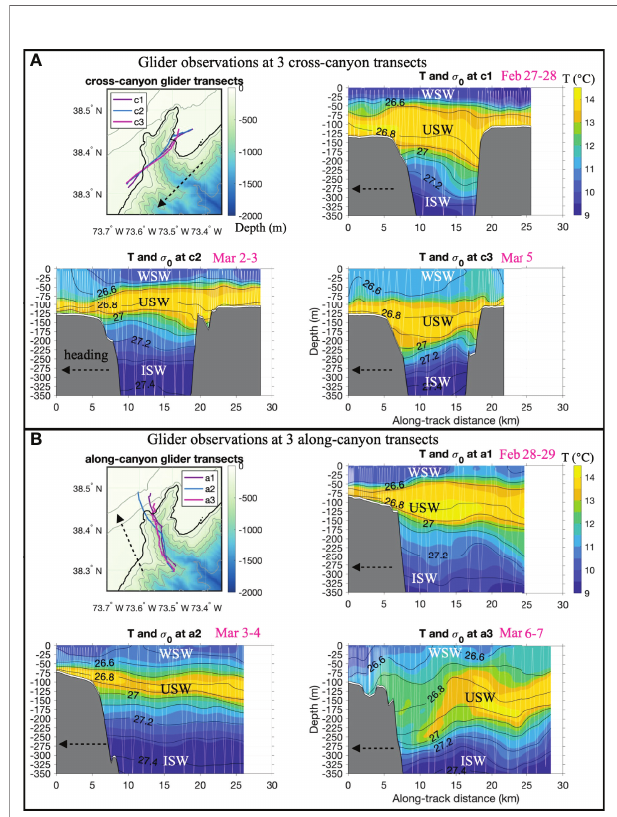
FIGURE 4 | Interpolated temperature (color) and density (contours) fi elds at (A) three repeated cross-canyon transects and (B) three repeated along- canyon transects from the glider survey. Typically in this mission, a glider transect took 20 to 30 hours to complete. Thin white lines in the temperature transects indicate glider tracks. Dashed black arrows indicate the glider ’ s heading. The cross-canyon transects c1, c2 and c3 were conducted February 27-28, March 2-3, and March 5, 2016, respectively. The along- canyon transects In a1, a2 and a3 were conducted on February 28-29, March 3-4, and March 6-7